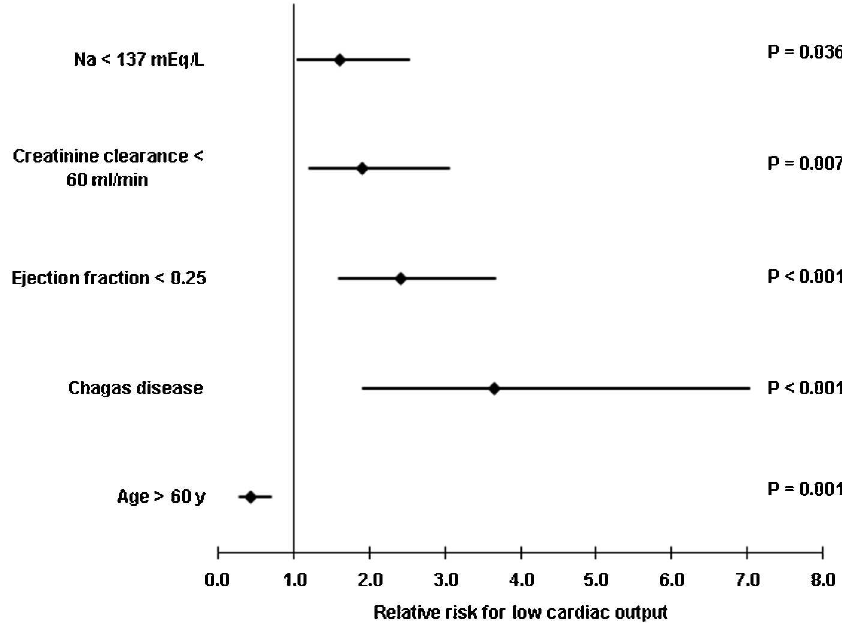
Figure 1 - Predictors of low cardiac output in decompesated heart failure.